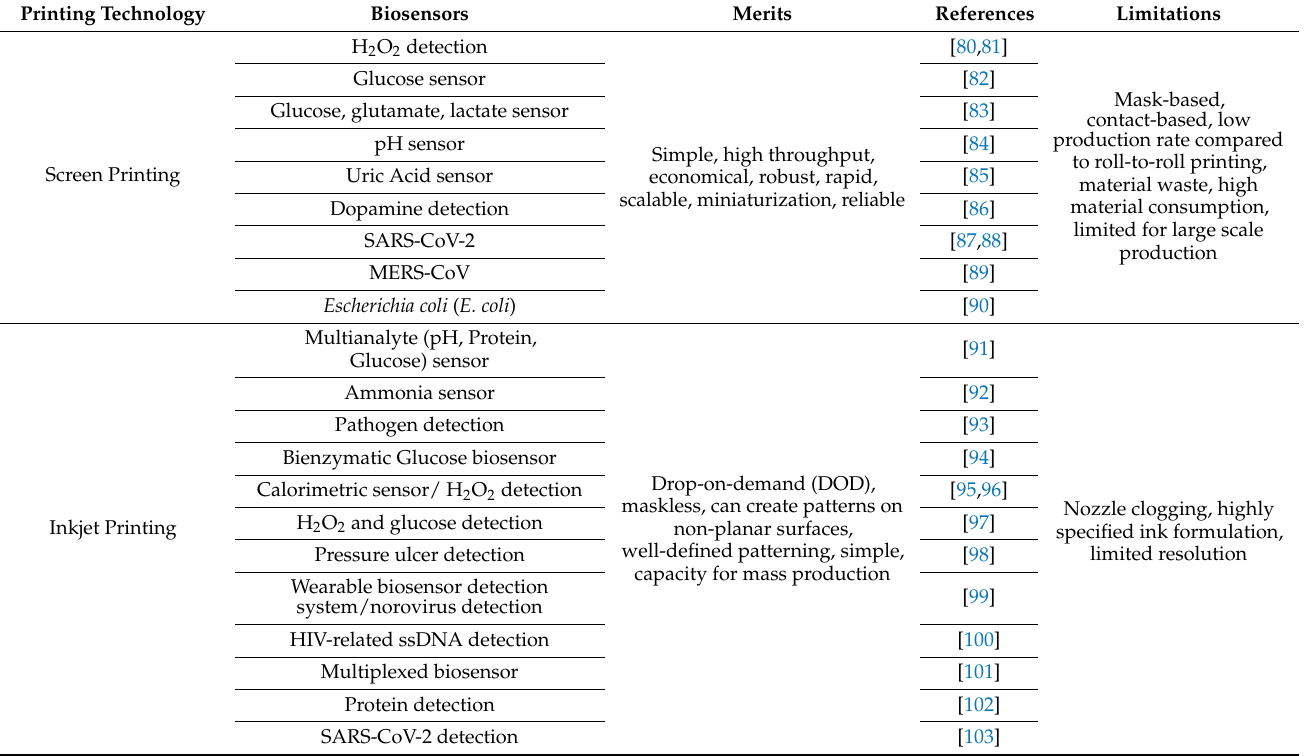
Table 1. Printing technologies used for biosensors